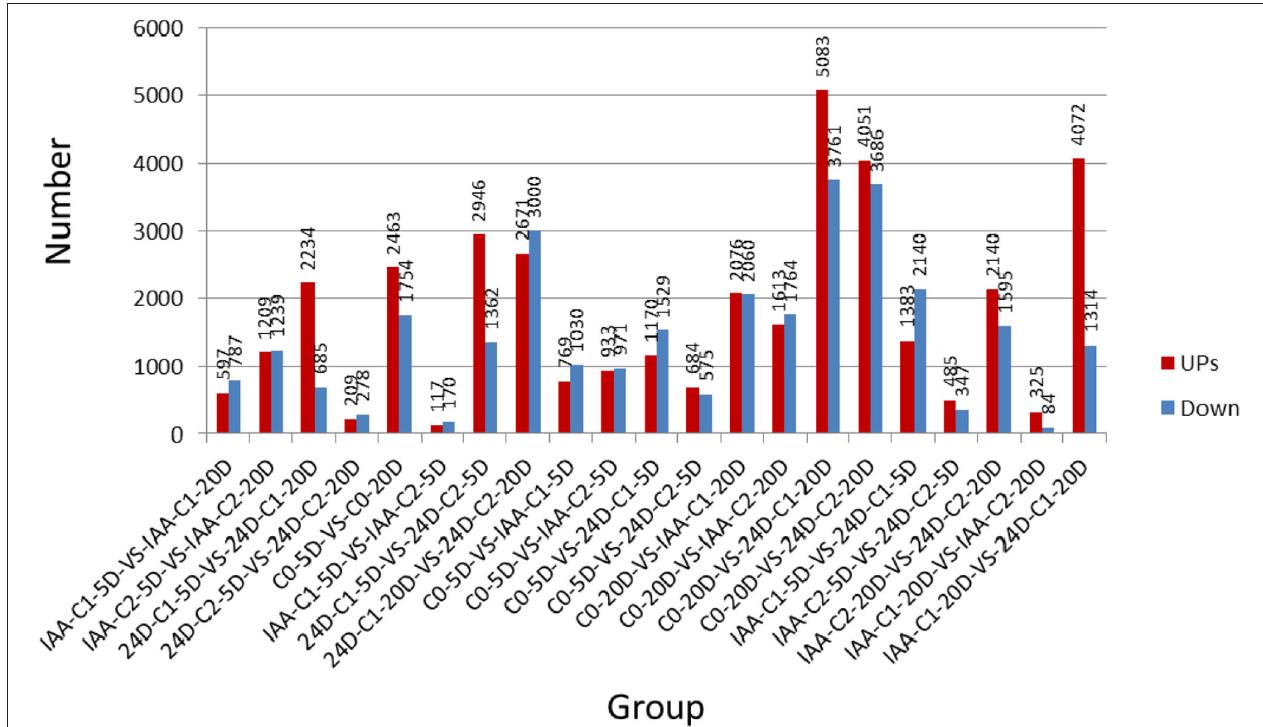
FIGURE 1 | The number of upregulated and down-regulated DEGs was compared between samples. IAA, indole acetic acid; 24D, 2,4-dichlorophenoxyacetic acid; C0, 0mg L − 1 ; C1, 0.025mg L − 1 ; C2, 0.05mg L − 1 ; 5D, 5 days’ treatment; 20D, 20 days’ treatment.